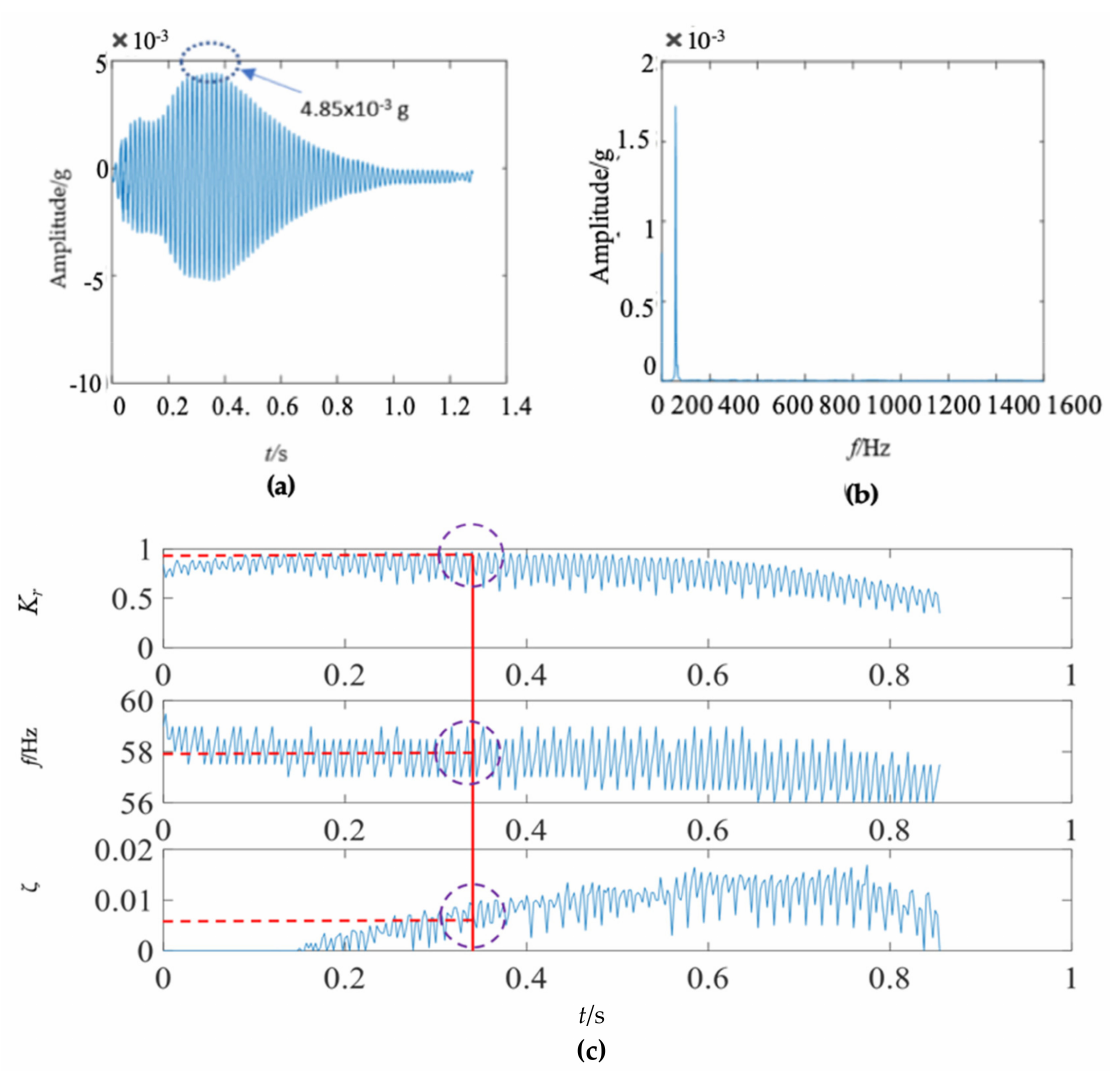
Figure 18. Second mode in the vibration response signal of the wooden utility pole labeled as 265173: ( a ) the vibration response of the second mode in the time domain, ( b ) the frequency spectrum of the second mode, ( c ) and the results of Laplace wavelet correlation filtering of the second mode.